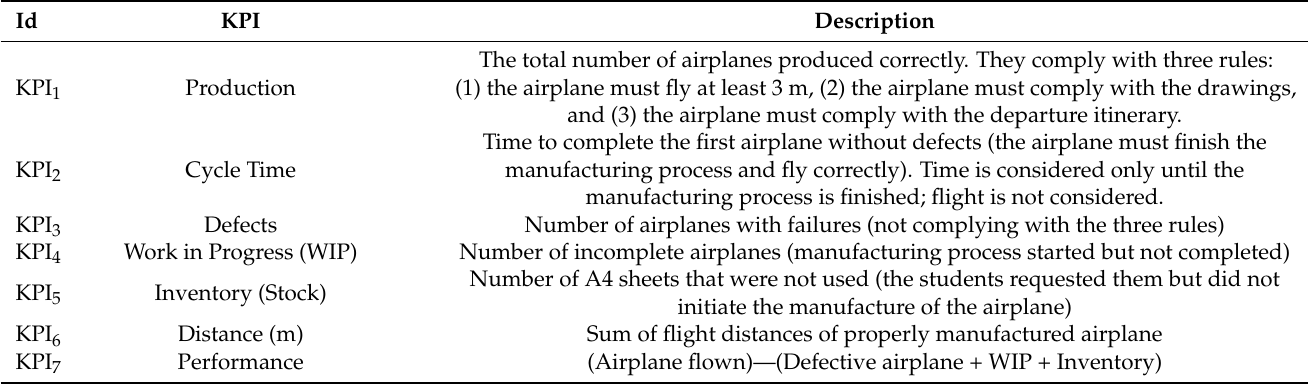
Table 3. Key Performance